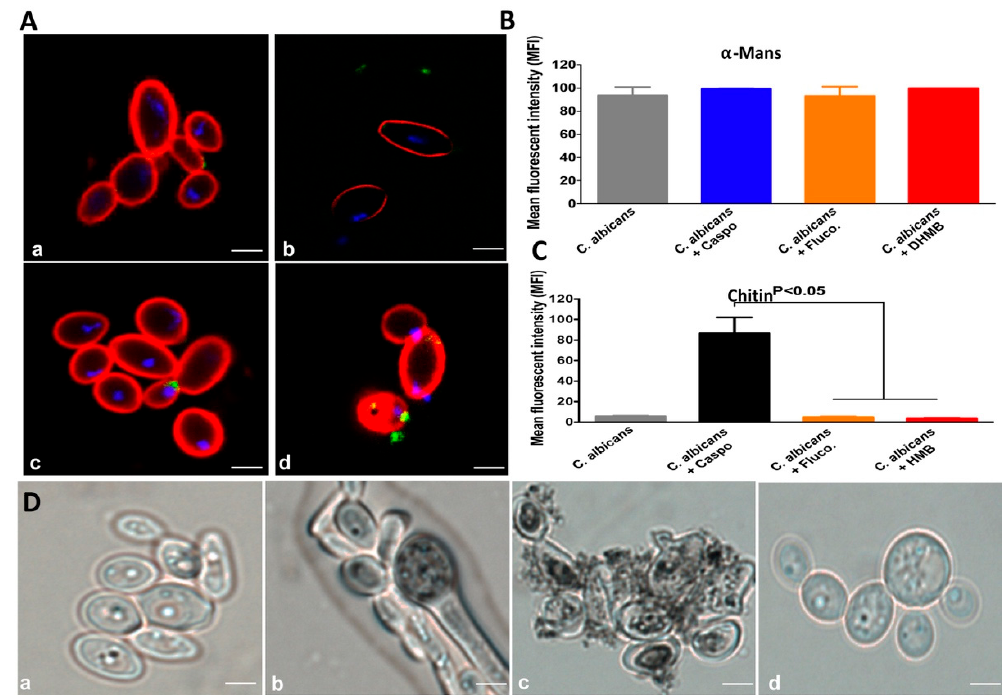
Figure 3. Effect of DHMB on modulation of chitin and α -mannan expression. ( A ) Confocal microscopic observation after antifungal challenge. C. albicans was treated with PBS ( a ) caspofungin ( b ), fluconazole ( c ) or DHMB ( d ) at a final concentration of 100 µM for 1 h and the fungal cell wall was analysed by confocal microscopy and flow cytometry; ( B ) Percentage of viable C. albicans cells labelled with concanavalin A. α -Mannans were labelled with concanavalin A-rhodamine; ( C ) Percentage of viable C. albicans cells labelled with WGA-IFTC. Chitin was labelled with wheat germ agglutinin-fluorescein isothiocyanate (WGA-IFTC); ( D ) Microscopic observation of the melanin pigments in C. albicans after DHMB treatment. ( a ) C. albicans cells grown without DOPA; ( b ) C. albicans grown with 1 mM DOPA; ( c ) C. albicans cells grown with DOPA and treated with caspofungin; ( d ), C. albicans cells were incubated with DOPA and challenged with DHMB. Bars 10 nm.